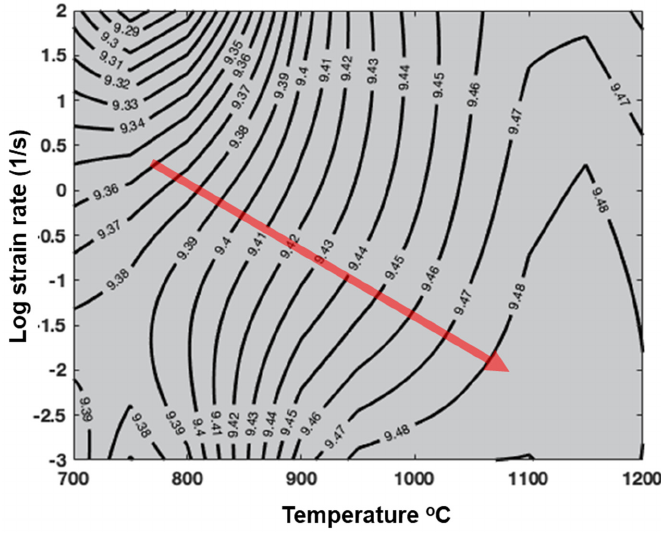
Figure 14. Process maps for TRIP steel composite with 10% zirconia constructed using the results of simulations. The trend of iso ‐ lines shown by red arrow is comparable with the experimental trend published earlier by Guk et al. [31].